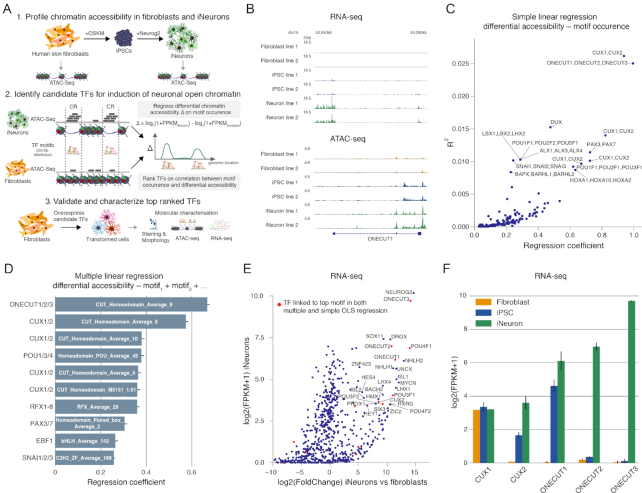
Identification of transcription factors associated with differential chromatin accessibility between human iNeurons and fibroblasts. (A) Overview of approach. (i) Chromatin accessibility in iPSC-derived iNeurons and fibroblasts was experimentally measured with ATAC-Seq. (ii) Differential chromatin accessibility (based on normalized ATAC-seq fragment count, see Methods) between iNeurons and fibroblasts was correlated with predicted transcription factor (TF) motif occurrence (based on cis-bp database (26)) to identify candidate TFs that could induce of iNeuronal OCRs when overexpressed in fibroblasts. (iii) The candidate TFs were validated and characterized. (B) Representative example of RNA-seq and ATAC-seq data used for identifying candidate TFs. Only one of two replicates per cell line is shown. FPM, fragments per million. (C) Simple linear regression of differential chromatin accessibility between iNeurons and fibroblasts on the TF motif occurrence for 580 motifs. The figure shows variance explained (R2) versus regression coefficient. Each point represents a separate regression. (D) Multiple linear regression of differential chromatin accessibility between iNeurons and fibroblasts on all 580 motifs simultaneously. The multiple regression identifies the effect of a TF motif on differential accessibility that cannot be explained by the other motifs. The figure shows the regression coefficient and its standard error. (E) Gene expression (RNA-seq) for the TFs that are linked to the motifs used for the ATAC-seq regression analysis. (F) Gene expression in fibroblasts, iPSCs and iNeurons for the top candidates from the ATAC-seq regression analysis. Plotted is the log2(1+FPKM) quantile normalized gene expression for CUX1, CUX2, ONECUT1, ONECUT2 and ONECUT3.